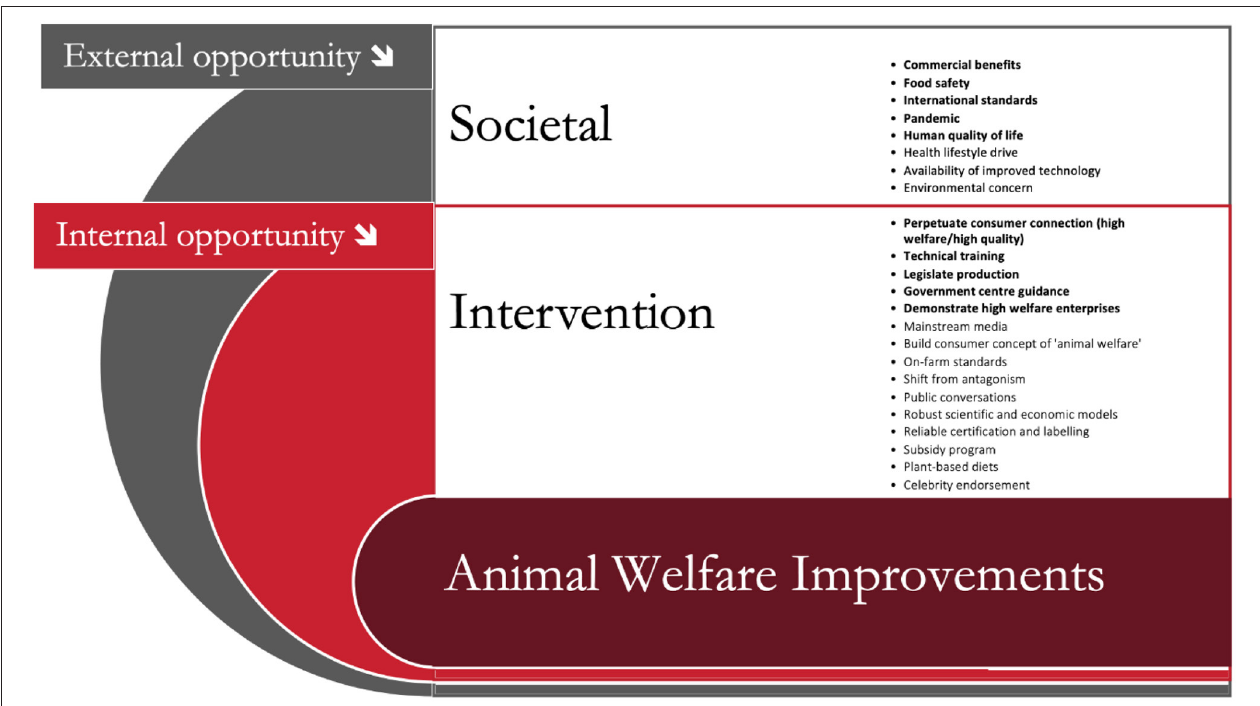
FIGURE 2 | Graphic representation of the relationship between themes of societal context (external opportunity) and interventions (internal opportunities) to improve animal welfare in China based on the findings presented in Table 5 above. The five most frequently supported internal and external ‘opportunities’ within the raw data are indicated in bold.